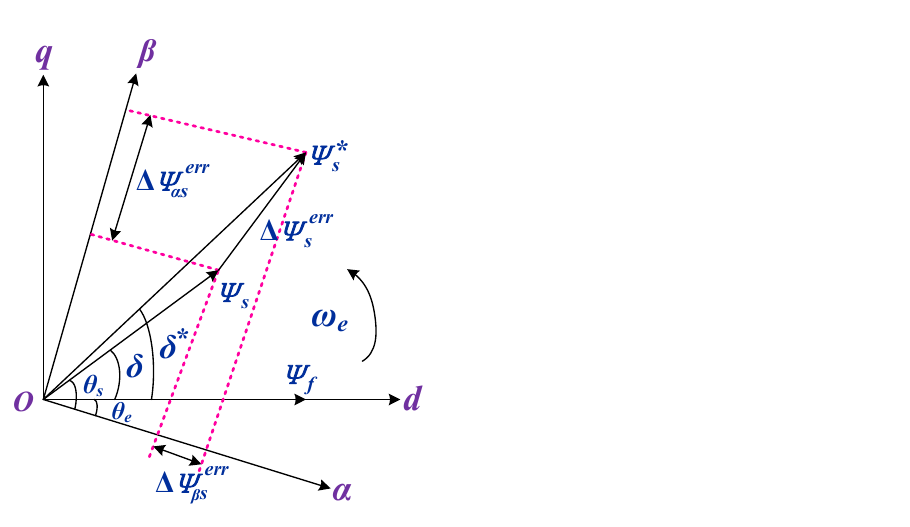
Figure 5. Error schematic of the stator flux linkage vector.